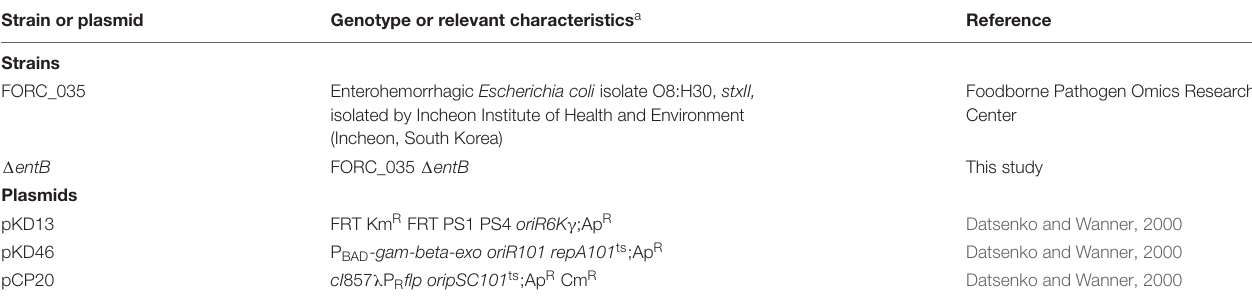
TABLE 1 | Bacterial strains and plasmids used in this study. Strain or plasmid Genotype or relevant characteristics a